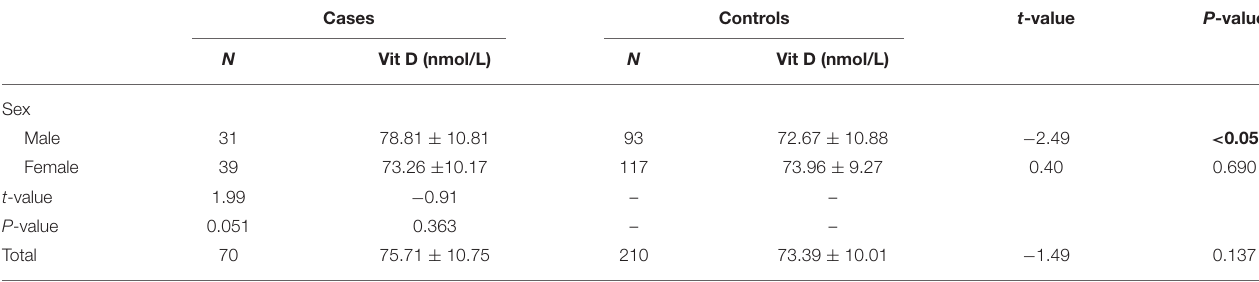
TABLE 1 | The distributions of vitamin D level in different sex